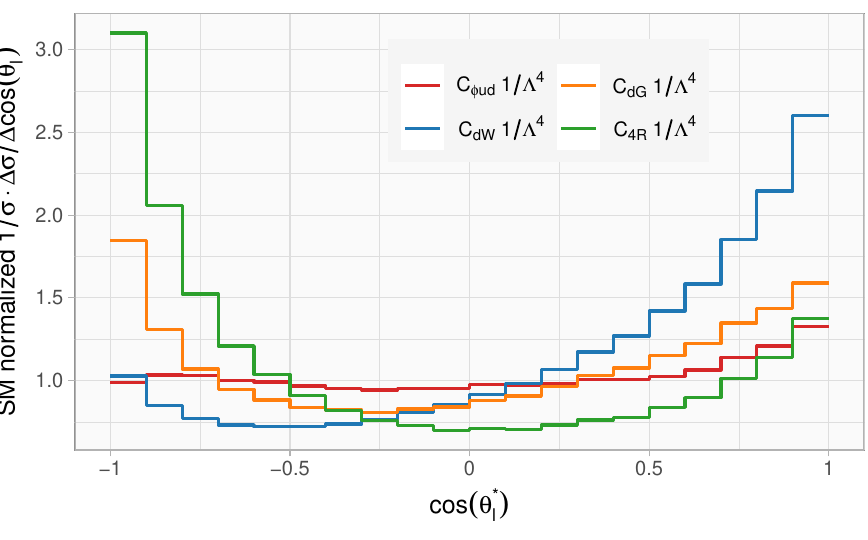
Figure 27. To itself and to the SM normalized SMEFT contributions to the cos (cid:18) (cid:3) at NLO in QCD . Results are presented for Q 33 operator Q 4 R